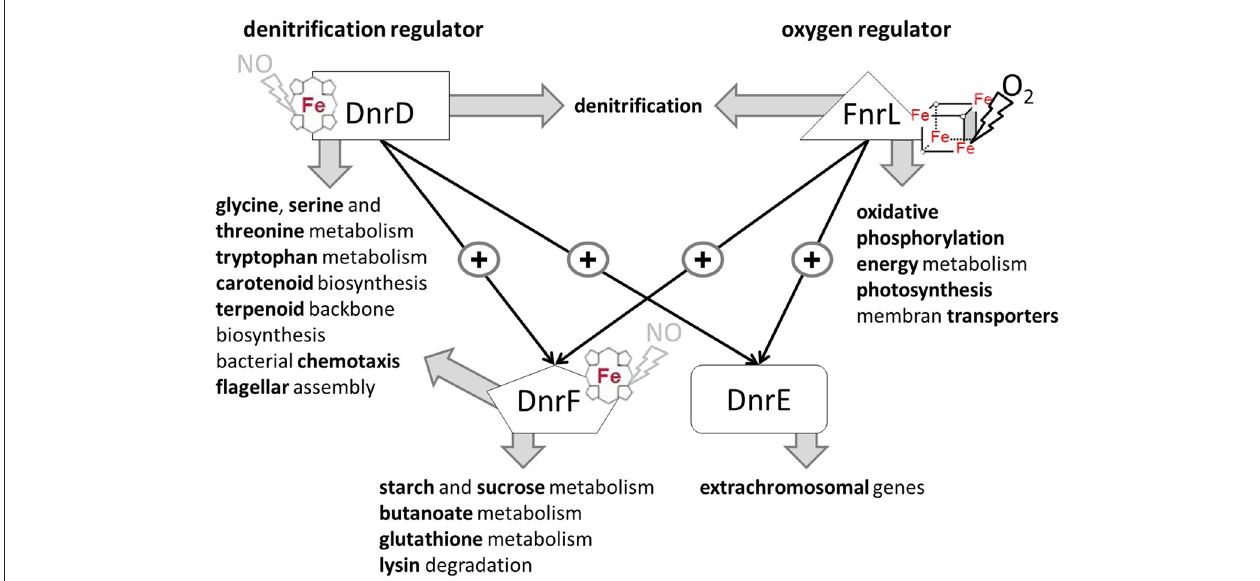
FIGURE 10 | Cascade type of regulatory network for the control of the aerobic-anaerobic transition by the Crp/Fnr like regulators in D. shibae DFL12 T . FnrL sensing oxygen via a bound oxygen-labile Fe-S cluster is the main oxygen regulator. DnrD most likely sensing NO via a bound heme cofactor is the main regulator for denitrification. the master regulators of the aerobic-anaerobic transition. They are inducing/repressing multiple transcriptional units of indicated processes. Moreover, expression of dnrE and dnrF , which in turn are controlling their own regulons, are modulating the activity of FnrL and DnrD. Interestingly, DnrE is mainly controlling plasmid-encoded